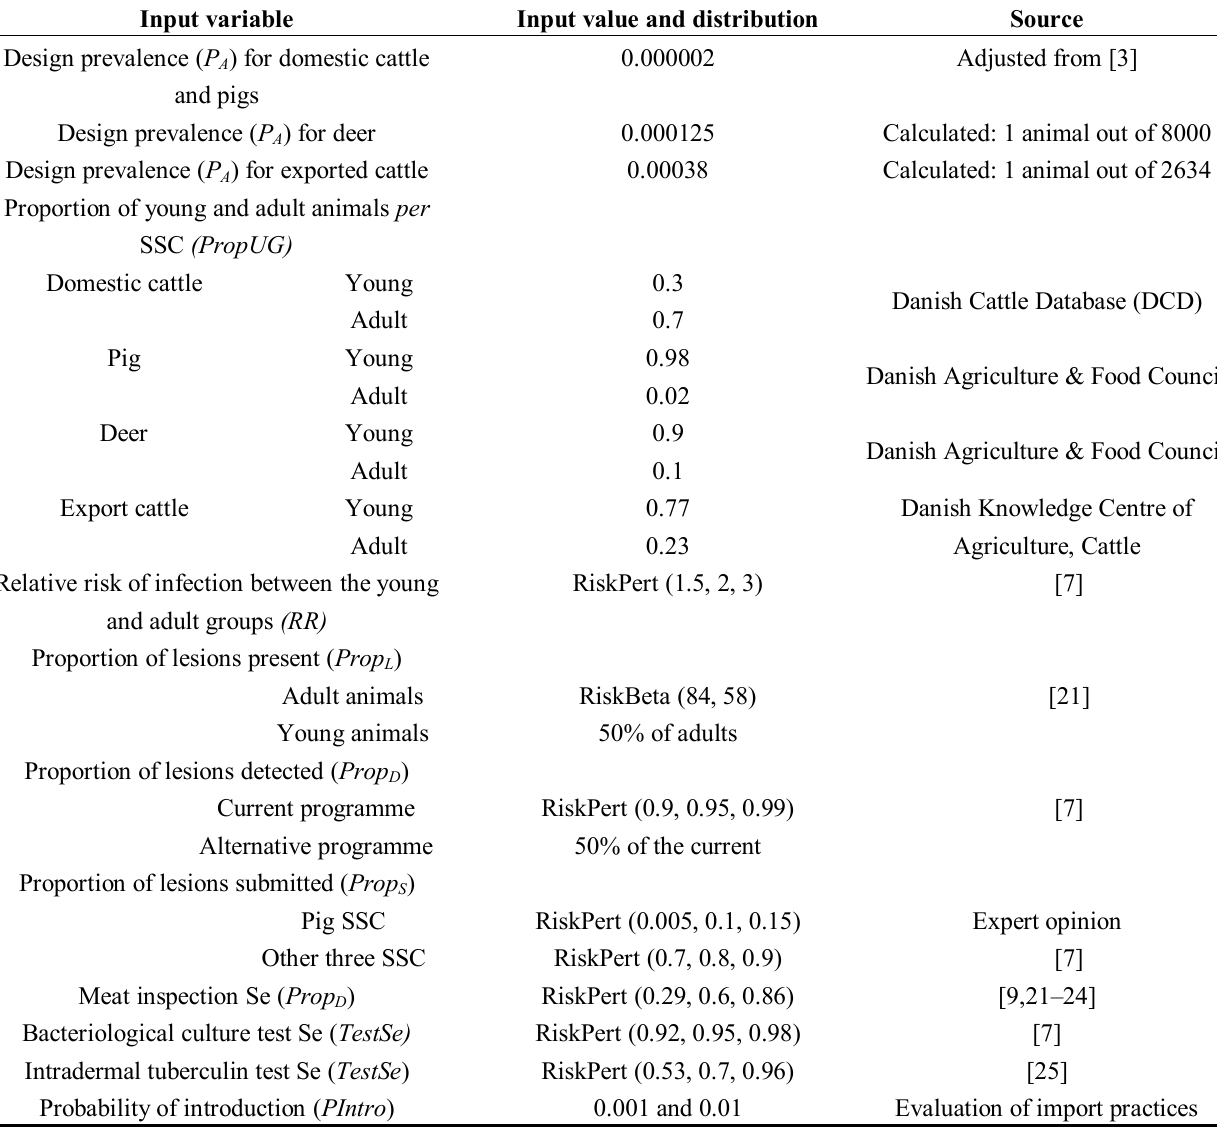
Table 2. Input variables used to estimate the probability of freedom from bovine tuberculosis in Denmark represented either as fixed values or distributions, and sources of